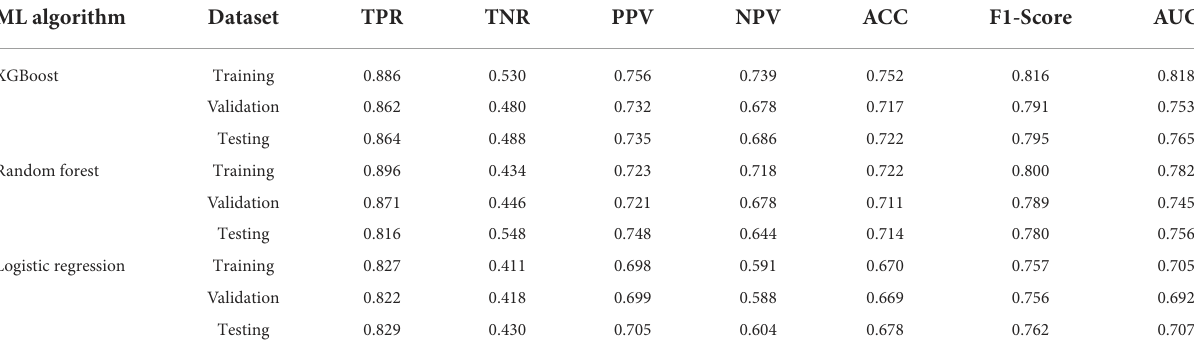
TABLE 3 The fitting results for the XGBoost, random forest, and logistic regression models for the training, validation, and testing sets. ML